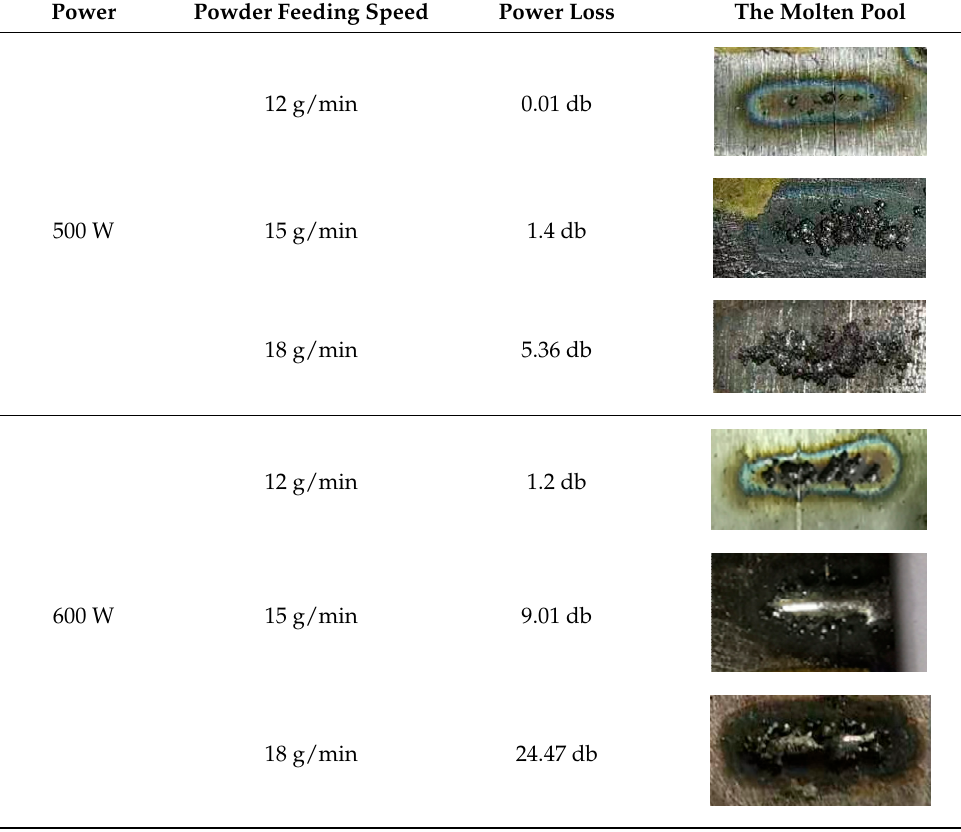
Figure 7. The structure diagram of the laser cladding experiment. Table 3. The selection of each parameter of the numerical analysis.